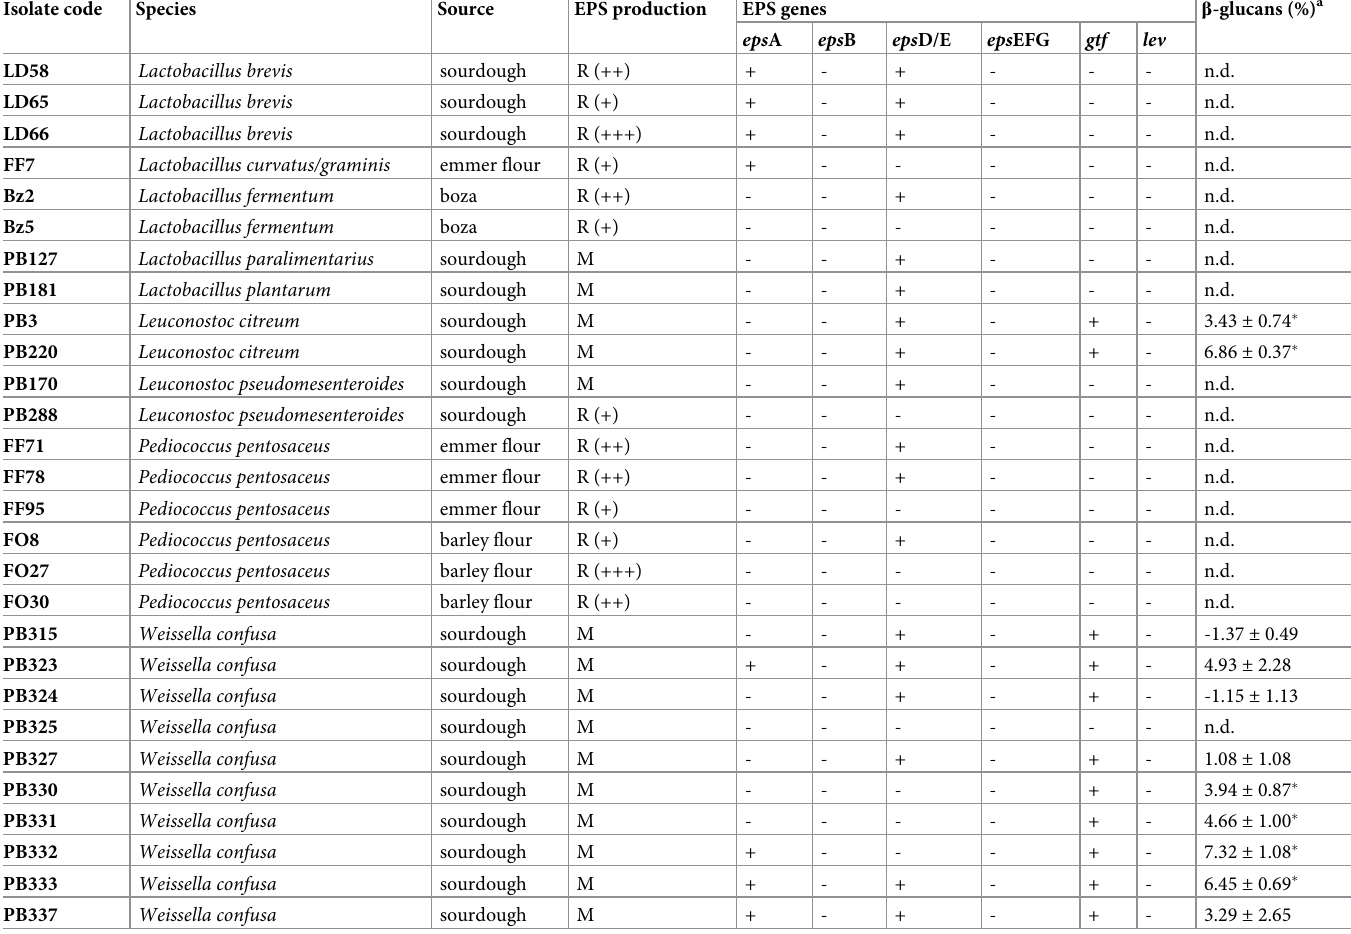
Table 3. Screening of lactic acid bacteria (LAB) for the exopolysaccharides (EPS) production on Sourdough Simulation Medium (SSM) added with sucrose (5%, w v -1 ), the genes involved in their production, and the variance of β -glucan content in barley flour medium before and after the fermentation. Isolate